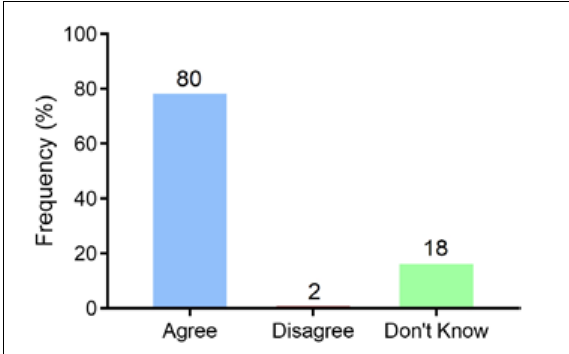
Figure 7. Frequency histogram for response to Question 2: ‘In Australia, a specialist orthodontist must also hold qualifications as a general